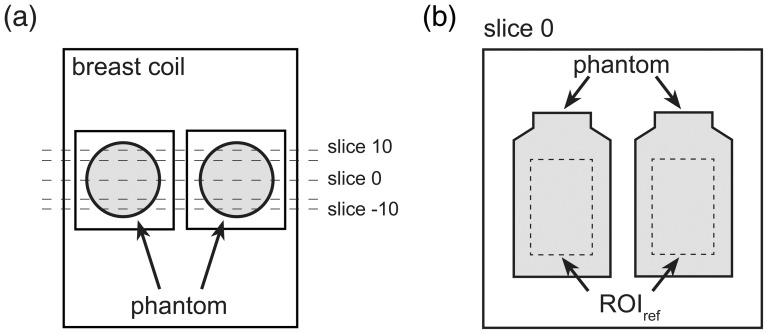
Schematic description of a) breast coil, phantom and acquisition slab (21 slices), as well as b) ROIref positioning.